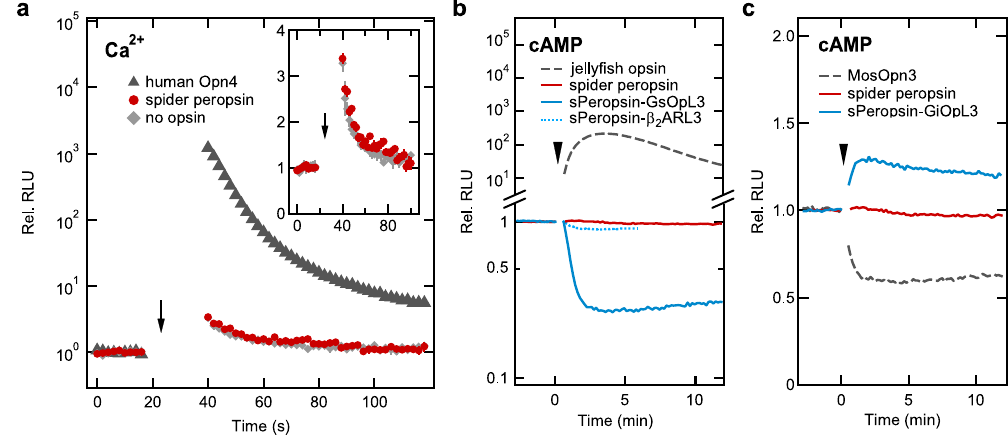
Figure 2. Bioluminescent assays for light-dependent changes in intracellular Ca 2 + and cAMP levels. ( a ) Aequorin Ca 2 + assay with HEK293 cells heterologously expressing human Opn4, spider peropsin, or no opsin. The inset shows the same data of spider peropsin and no opsin on a linear scale. Averaged values for three samples are shown with error bars (s.e.m.). ( b ) GloSensor cAMP assay with HEK293 cells expressing jellyfish opsin, spider peropsin, sPeropsin-GsOpL3, or sPeropsin- β 2 ARL3. ( c ) GloSensor cAMP assay with HEK293 cells expressing MosOpn3 or sPeropsin-GiOpL3. The same data of spider peropsin shown in Fig. 2b is shown here for comparison. Cells were illuminated with white light ( a ; arrows) or green light ( b , c ;